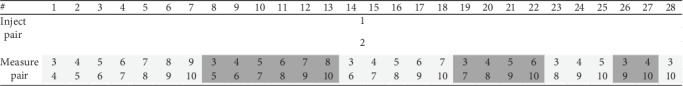
Electrode pairs for current application and voltage measurement when current is applied through the first and second electrodes.